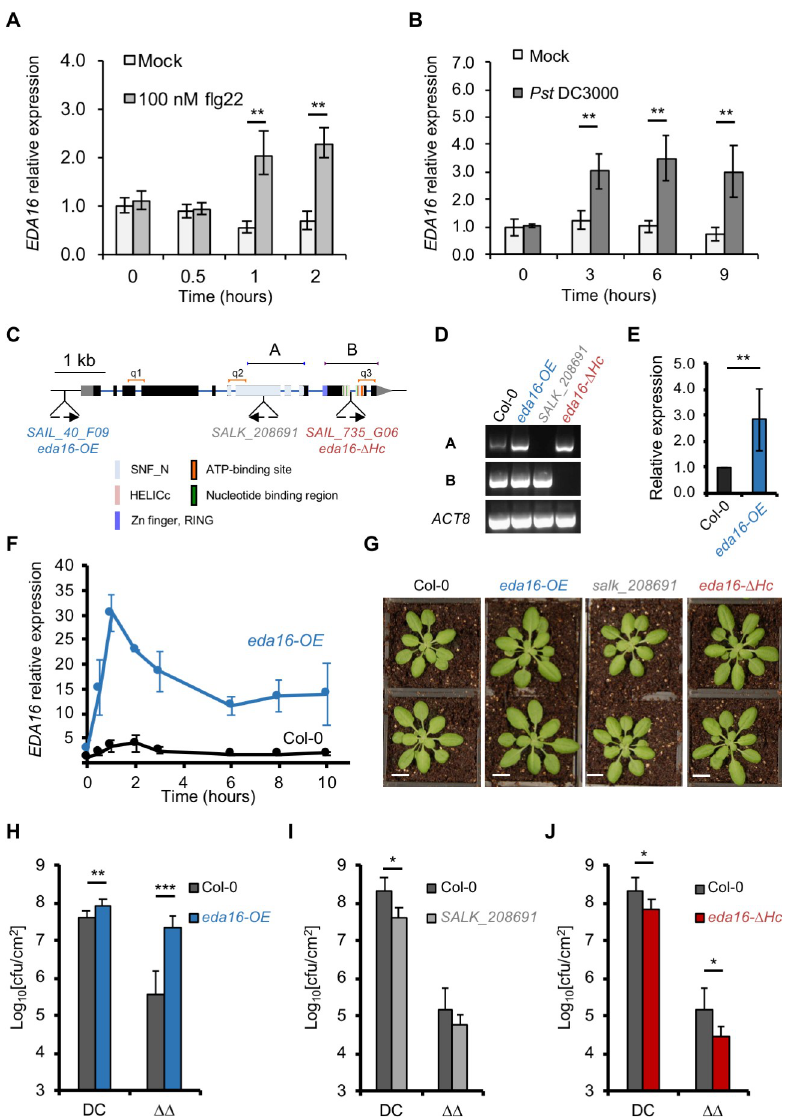
Fig 3. EDA16 is a negative regulator of plant immunity. (A) EDA16 expression is induced by flg22 elicitation. Accumulation of EDA16 transcript was assessed by qPCR in 2-week-old Col-0 seedlings elicited with 100 nM flg22 or water (mock). Values are average of three biological repeats ± SE presented as fold induction compared with mock- treated sample at time 0. (B) Bacterial infection induces EDA16 expression. 5-week-old Col-0 plants were infiltrated with Pst DC3000 or 10 mM MgCl 2 (mock). EDA16 expression was assessed by qPCR. Values are average of three biological repeats ± SE presented as fold induction compared with mock-treated sample at time 0. Labelled values are statistically different as established by two-sided T-test p-values: �� < 0.01. (C) Schematic representation of the T-DNA insertions in EDA16 gene. Boxes and solid lines denote exons and introns, respectively. T-DNA insertions and mutant names are indicated below the gene structure. The different functional domains of EDA16 are color-coded. Primers used for RT-PCR presented in panel D and corresponding PCR products are indicated above the gene structure ( a , b ). qPCR primers used in panels E and F are indicated above the gene structure (q1, q2, q3). (D) Mutant characterization by cDNA integrity. RT-PCR analysis of EDA16 gene expression in homozygous eda16 mutants and Col-0 plants. The amplified fragments ( a and b ) are indicated in C. ACT8 was used as a control. (E) SAIL_40_F09 mutant is an of EDA16 over-expresser. Accumulation of EDA16 transcript was assessed by qPCR in 2-week-old Col-0 and SAIL_40_F09 ( eda16-OE ) by averaging the results of 3 primer pairs (q1, q2 and q3), presented in panel C. Values are average of three biological repeats ± standard deviation presented as fold induction compared with Col-0 at time 0. (F) The SAIL_40_F09 mutant is an inducible over-expresser of EDA16 . Accumulation of EDA16 transcript was assessed by qPCR in 2-week-old Col-0 and SAIL_40_F09 ( eda16-OE ) mutant plants as in panel E, after elicitation with 100 nM flg22 at the indicated times. Values are average of three biological repeats ± standard deviation presented as